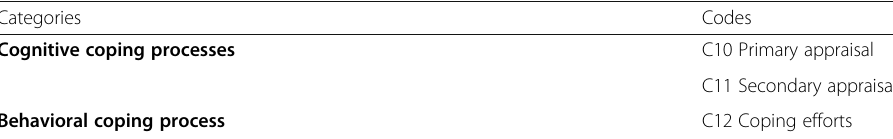
Table 4 Coping coding scheme Categories